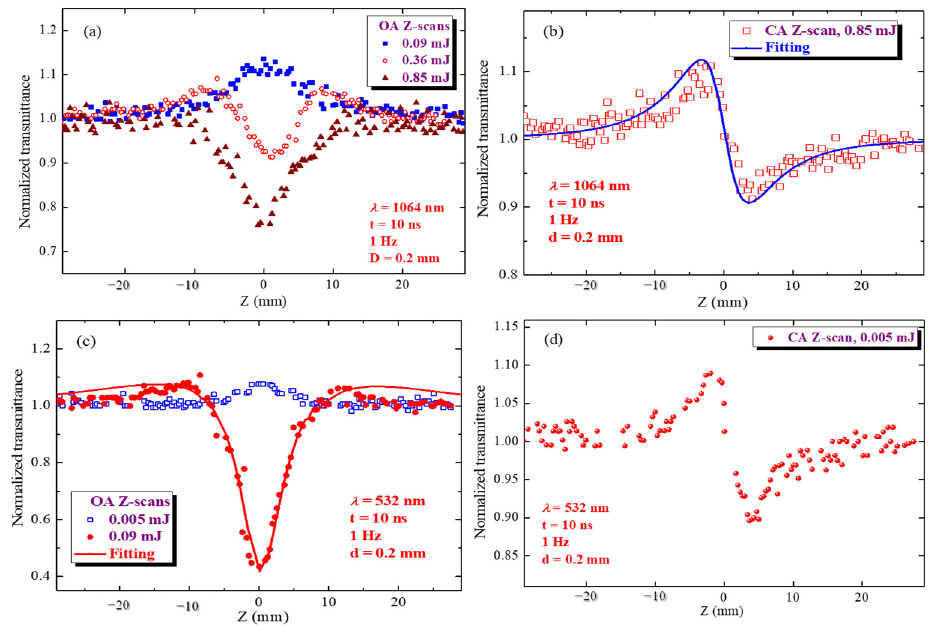
Figure 7. ( a , c ) Open-aperture scans and ( b , d ) closed-aperture of HgS QD suspension using 1064 nm pulses ( a , b ) and 532 nm pulses ( c , d ). Reprinted with permission from Ref. [31], 2022, MDPI.